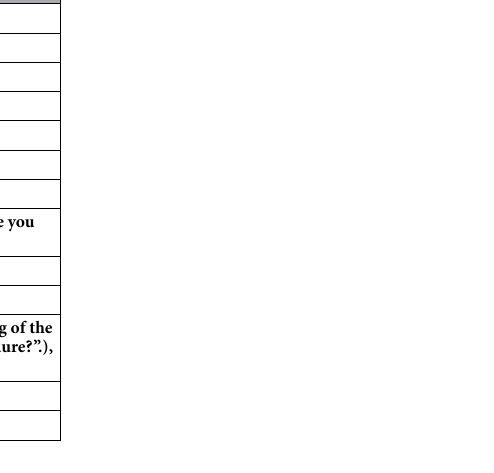
Table 3. Description of the study